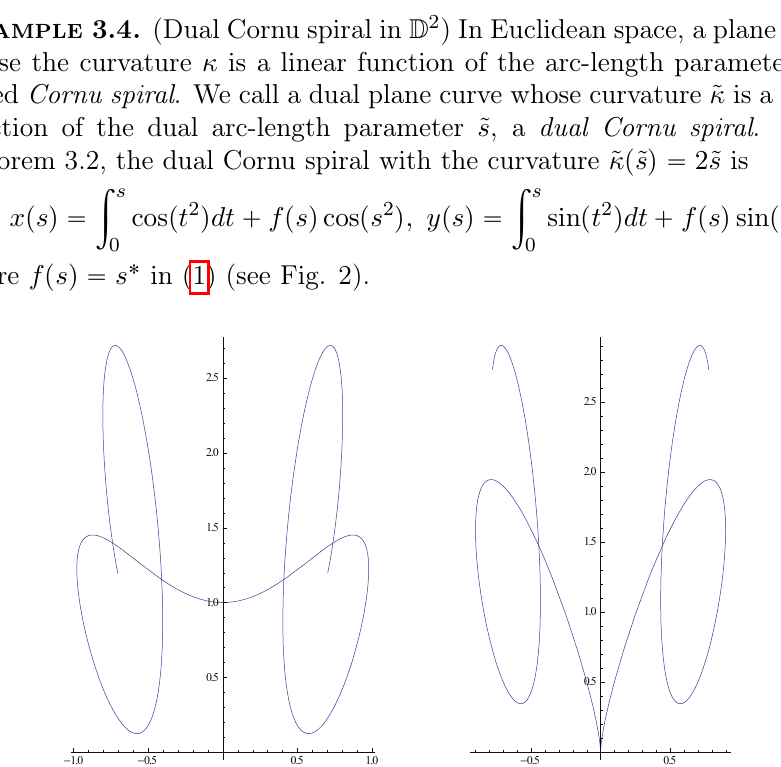
Fig. 2. A dual spiral is a product curve of above two curves in D